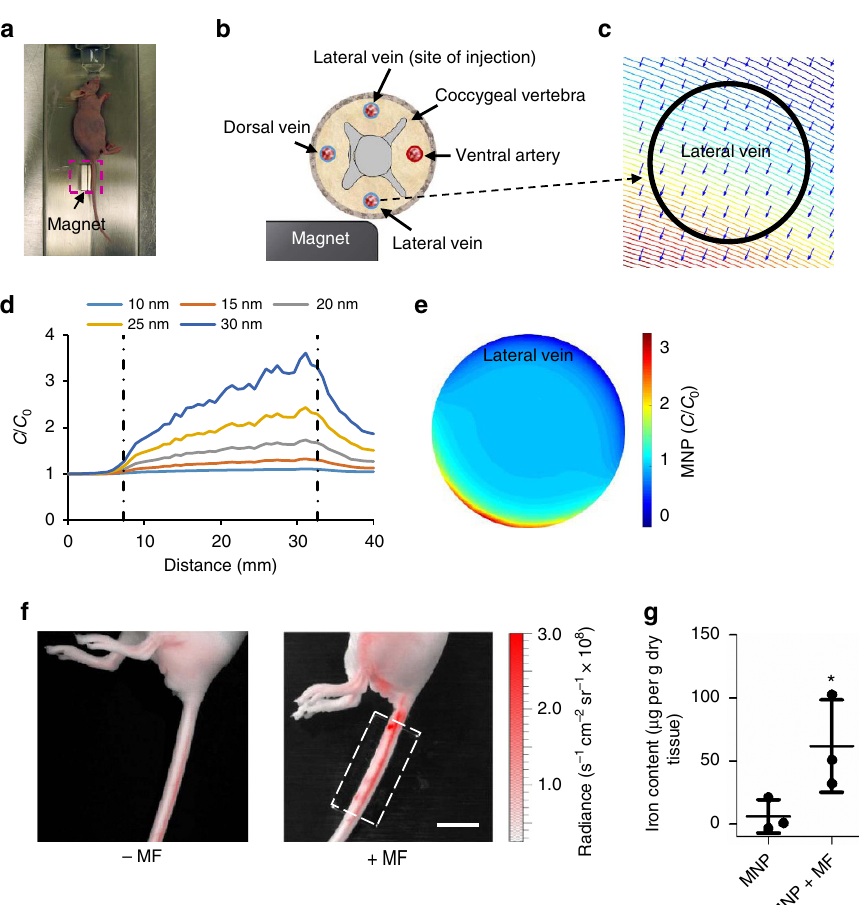
Figure 5 | In vivo magnetic targeting. ( a ) Set-up of the in vivo experiment. An athymic nude mouse was anaesthetized with isoflurane with one of its lateral tail veins aligned with the edge of a rare-earth magnet. ( b ) A schematic diagram of the mouse tail and the magnet. ( c ) Simulated distributions of magnetic flux density and magnetic force. The circle represents the lateral tail vein near the magnet. ( d ) Simulated concentration profiles of MNPs of different sizes on the vessel wall close to the edge of the block magnet. Dashed lines mark the ends of the block magnet. Fluctuations in the concentration are caused by the interpolation of numerical results. ( e ) Simulated concentration profile of 33nm MNPs in the cross-section of the lateral tail vein. ( f ) Magnetic targeting of 33nm MNPs labelled with DiR. The dashed box marks the segment of the tail next to the magnet. The NIR fluorescence signal (ex/em ¼ 710nm/780nm) was pseudocoloured as indicated with the colour bar. Accumulation of MNPs increased along the blood flow direction from the distal to the proximal end of the tail. Scale bar, 10mm. ( g ) MNPs in the mouse tails quantified by a superconducting quantum interference device (SQUID; mean ± s.d.; n ¼ 3; * P o 0.05).